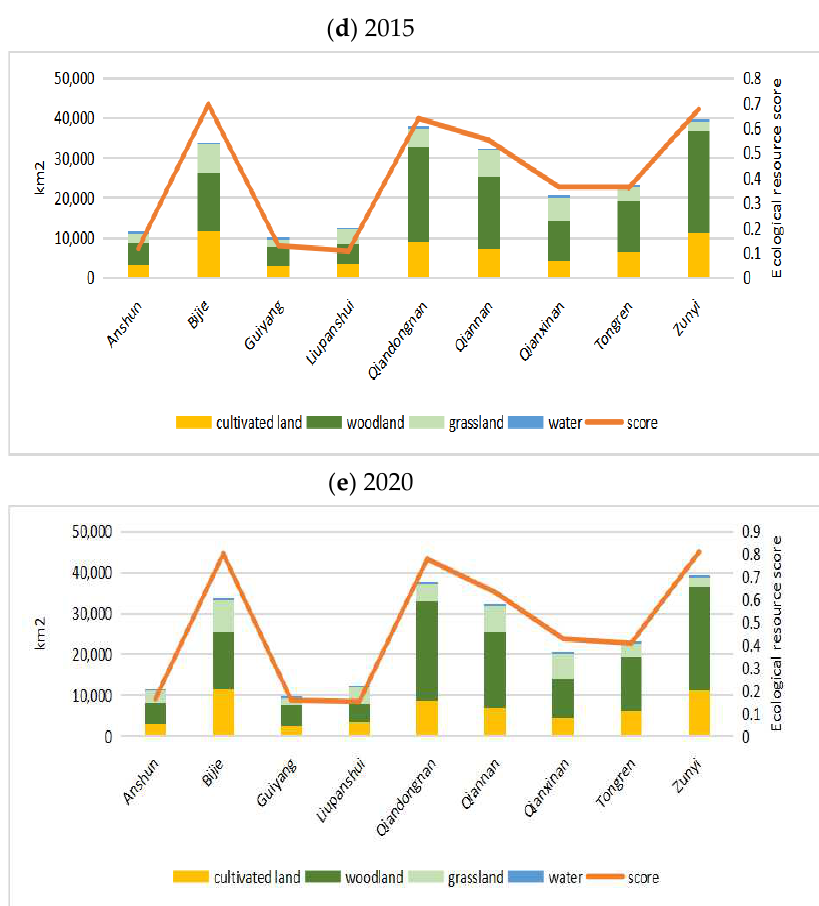
Figure 5. Score of ecological resources of different cities in Guizhou Province.